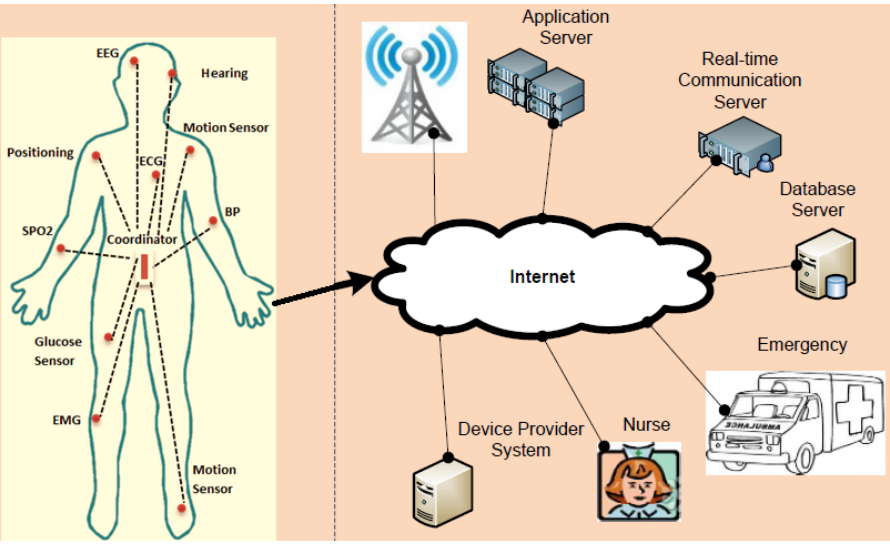
Figure 6. WBASN’s global connectivity.